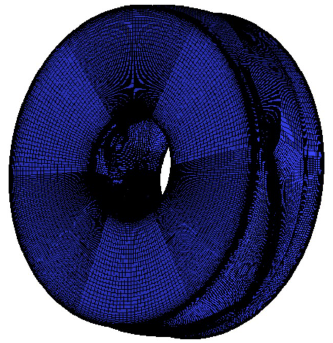
Figure 2. Grid of impeller domain.